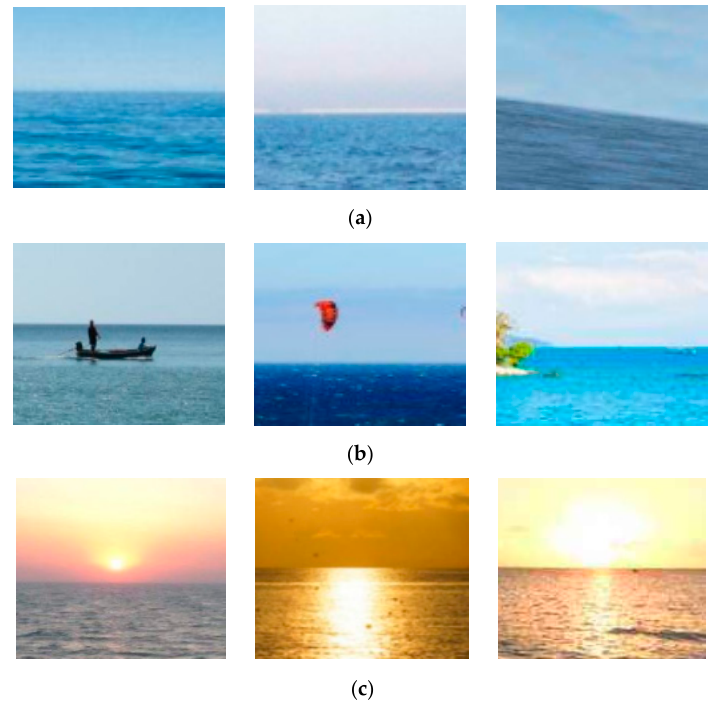
Figure 4. The color feature of the horizon line segments: ( a ) The image examples contain the horizon line with blue sea and white/blue sky; ( b ) The image examples contain the horizon line with blue sea, white/blue sky and other objects, such as boat, bird, and island; ( c ) The image examples contain the horizon line with the setting sun scene.